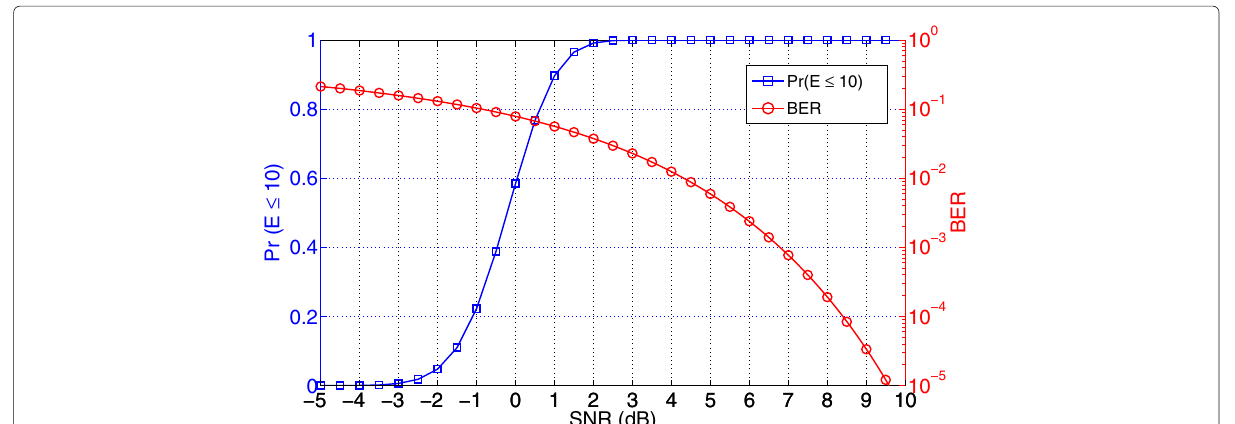
Fig. 3 Bit error probability and probability of having fewer than or equal to 10 errors out of 127 bits for an AWGN channel with BPSK